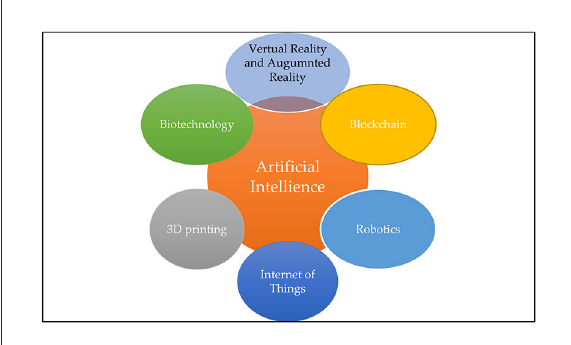
FIGURE2 Technologies driving change in the Fourth Industrial Revolution. Source: The analysis of the author.